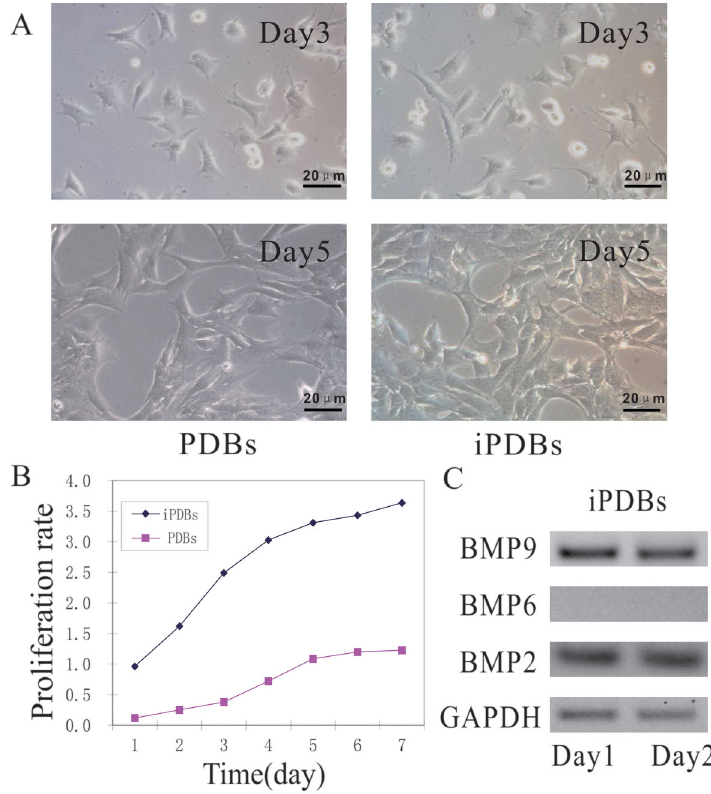
Figure 1. Cell morphology, proliferation activity, and bone morphogenetic proteins (BMPs) endogenous expression. The preodontoblasts (PDBs) and immortalized preodontoblasts (iPDBs) were seeded at a low con fl uence ( A ) and subjected to MTT assays at the indicated time points (scale bars 20 m m). The iPDBs had a higher growth rate than PDBs ( B ). The endogenous expressions of BMP2, 6, and 9 were measured using semi-quantitative RT-PCR assay in iPDBs ( C ). Each assay was done in